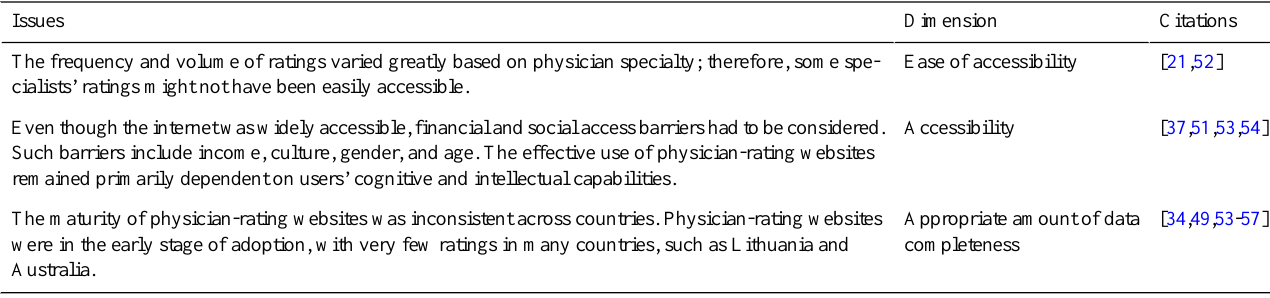
Table 5. Accessibility data quality